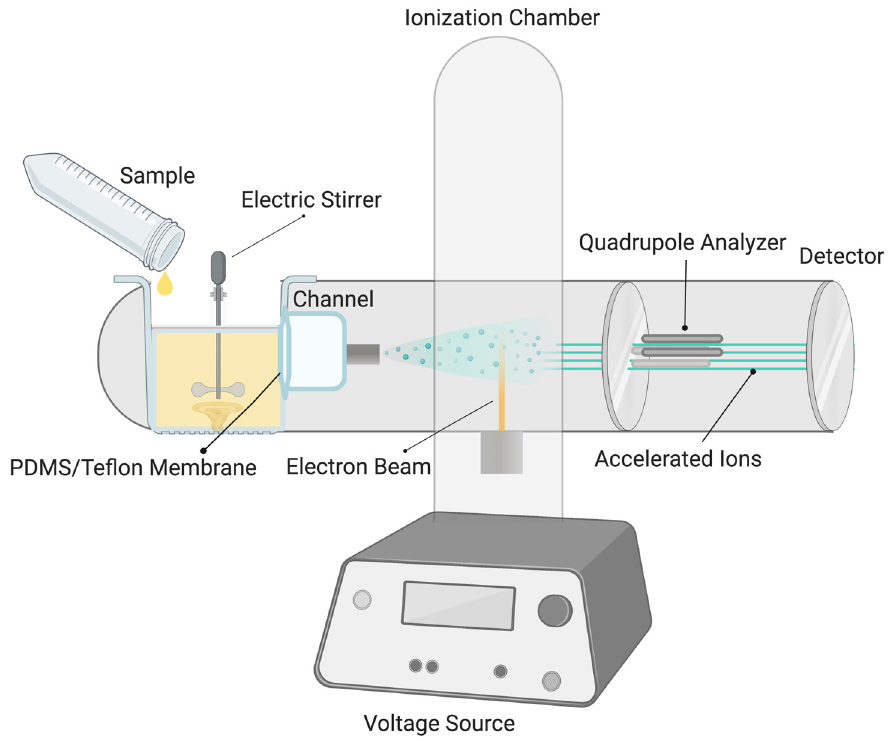
Figure 1. Schematic representation of Membrane-Inlet Mass Spectrometry (MIMS) (Created in BioRender.com (accessed on 22 December 2022)).